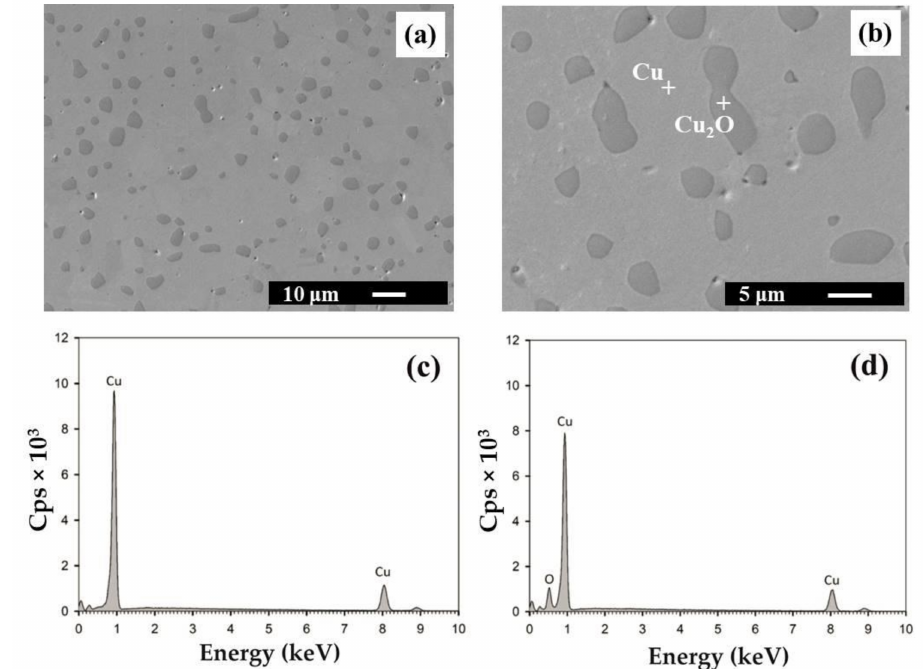
Figure 1. SEM microstructure of the HIPed Cu sample at magnification 1000 × ( a ) and 3000 × ( b ). Cu and Cu 2 O are colored in light and dark grey, respectively. EDS spectra were obtained by point analysis in Cu ( c ) and Cu 2 O ( d ).